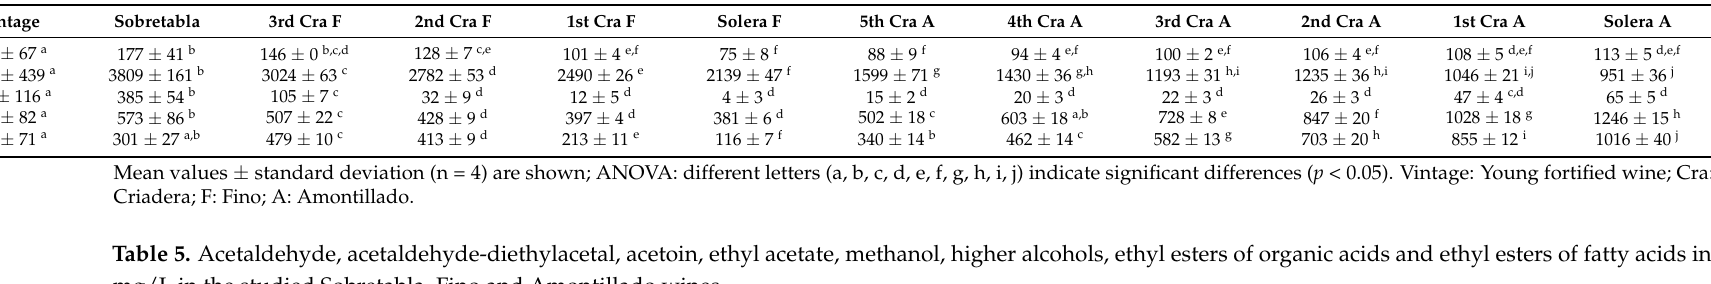
Table 4. Organic acids (mg/L) in the studied Sobretabla, Fino and Amontillado wines.